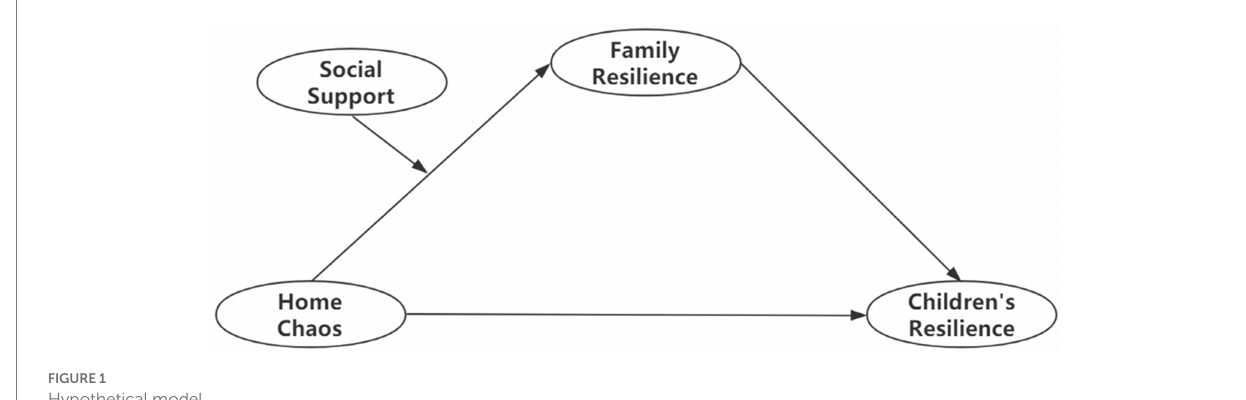
FIGURE 1 Hypothetical model.